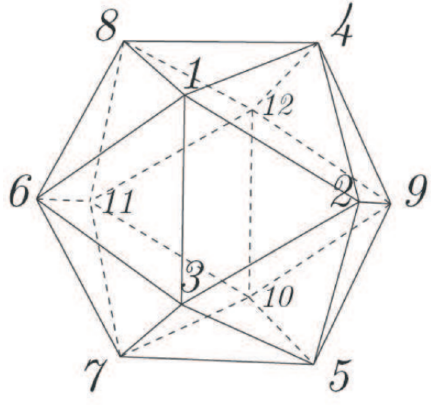
Figure 9. Proper rotations of an Icosehedron is isomorphic to A a 2 = b 5 = ( ab ) 5 = e , where a corresponds to rotation by (cid:25) about the edge joining vertices 1 and 2 and b corresponds to clockwise rotation by axis passing through the centre of the face 10-11-12. The 12 vertices exchange under A 5 as a : ( x 1 , x 2 , x 3 , x 4 , x 5 , x 6 , x 7 , x 8 , x 9 , x 10 , x 11 , x 12 ) x 4 , x 3 , x 8 , x 9 , x 12 , x 5 , x 6 , x 11 , x 10 , x 7 ), b : ( x 1 , x 2 , x 3 , x 4 , x 5 , x 6 , x 7 , x 8 , x 9 , x 10 , x 11 , x 12 )